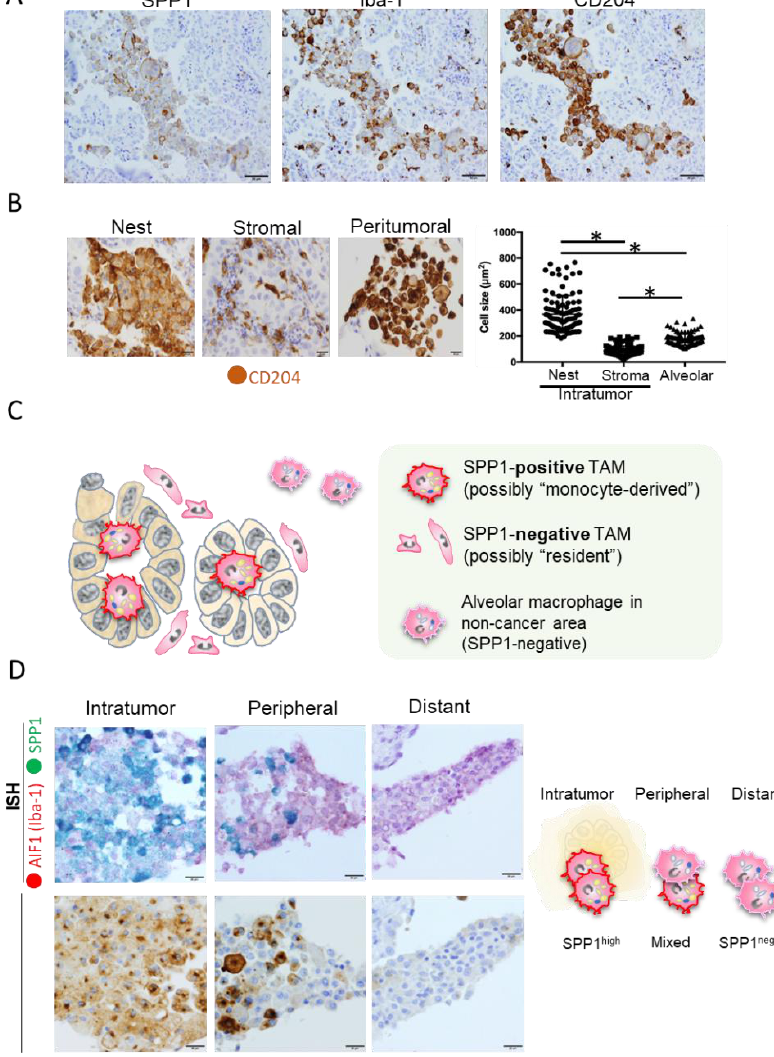
Figure 1. SPP1 expression in macrophages. ( A ) Representative images of IHC staining of SPP1, Iba-1, and CD204 expressions in serial sections of lung adenocarcinoma. Iba-1 and CD204 were used as specific markers for macrophages. Scale bar; 50 µ m. ( B ) The size of CD204-positive macrophages infiltrating the cancer nest, stroma, and peritumoral area was evaluated using ImageJ software. Macrophages detected in the cancer nest and stroma were referred to as TAMs, and macrophages in the peritumoral area were referred to as alveolar macrophages. *; p value < 0.05. Scale bar; 20 µ m. ( C ) Schematic illustration of macrophage phenotypes in and around cancer tumors. ( D ) In situ hybridization (ISH) analyses of AIF1 (red) and SPP1 (green) and IHC of SPP1 were performed in serial section, and figures in intratumor, peripheral, and distant areas are presented. Scale bar; 20 µ